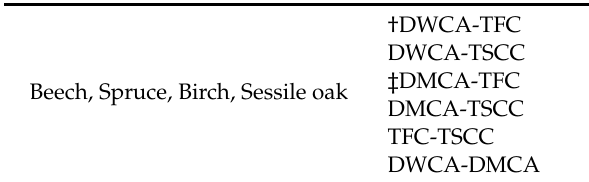
Table 1. The statistical analysis on each measured